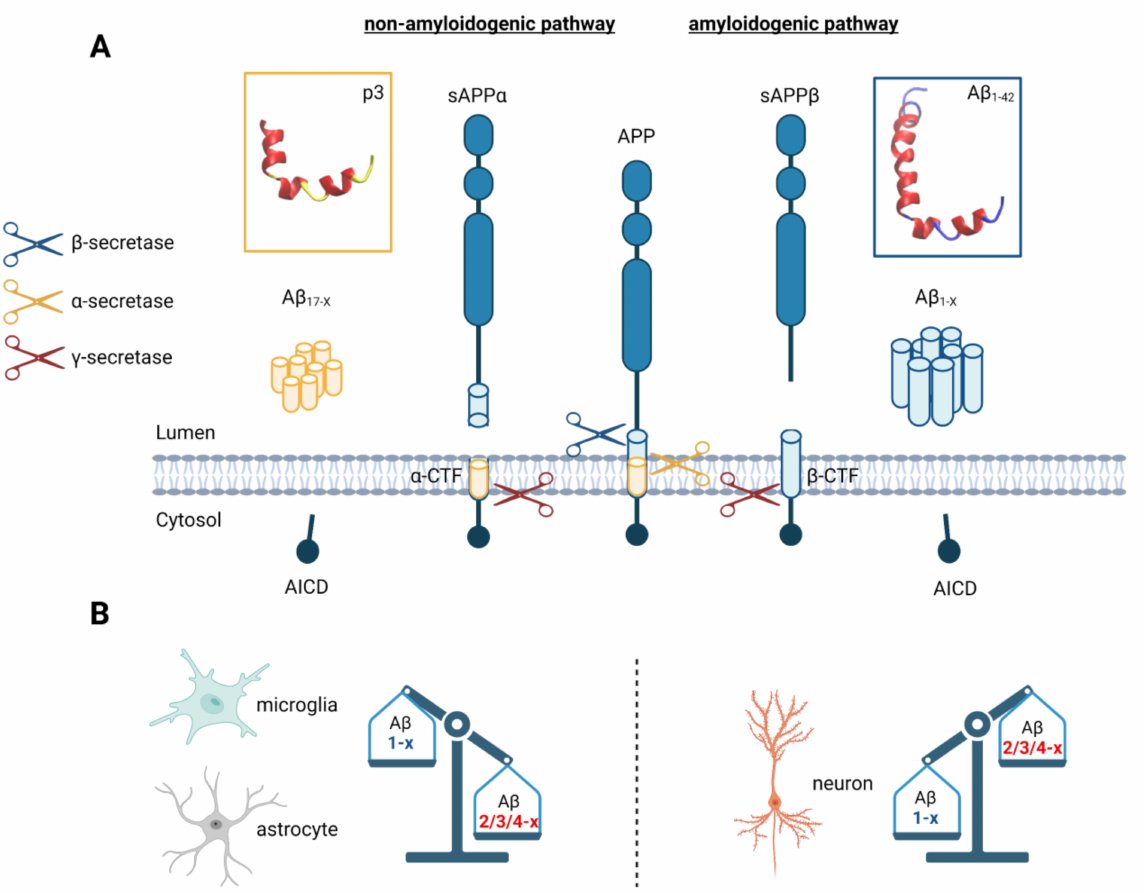
Figure 3. The amyloidogenic and non-amyloidogenic pathway of APP processing. ( A ) The non- amyloidogenic pathway is starting by α -secretase cleavage of APP which leads to the release of soluble APP α (sAPP α ) and concomitant generation of the α -C-terminal fragment ( α -CTF). Subsequent cleavage of the α -CTF by γ -secretase leads to the secretion of the small fragment p3 and release of the APP intracellular C-terminal domain (AICD) into the cytosol. In the amyloidogenic pathway, APP is first cleaved by β -secretase to produce soluble APP β (sAPP β ) and the membrane retained β -C-terminal fragment ( β -CTF). Further processing of the β -CTF by γ -secretase releases AICD as well as the A β peptide, which can form neurotoxic oligomers. A β production was reported to be higher in neuronal cultures compared to astrocytes or microglia cultures [95,96]. 3D structures (PDB: 1IYT) are based on NMR experiments by Crescenzi and colleagues [97]. ( B ) Glial cells mainly produce N-abridged A β peptides (up to 60%) such as A β 2/3-X or A β 4/5-x , while neurons produce predominantly A β peptides starting at position 1 (80%)